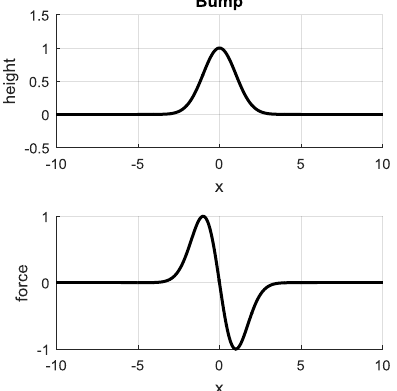
Figure 6. Illustration of the bump force model.